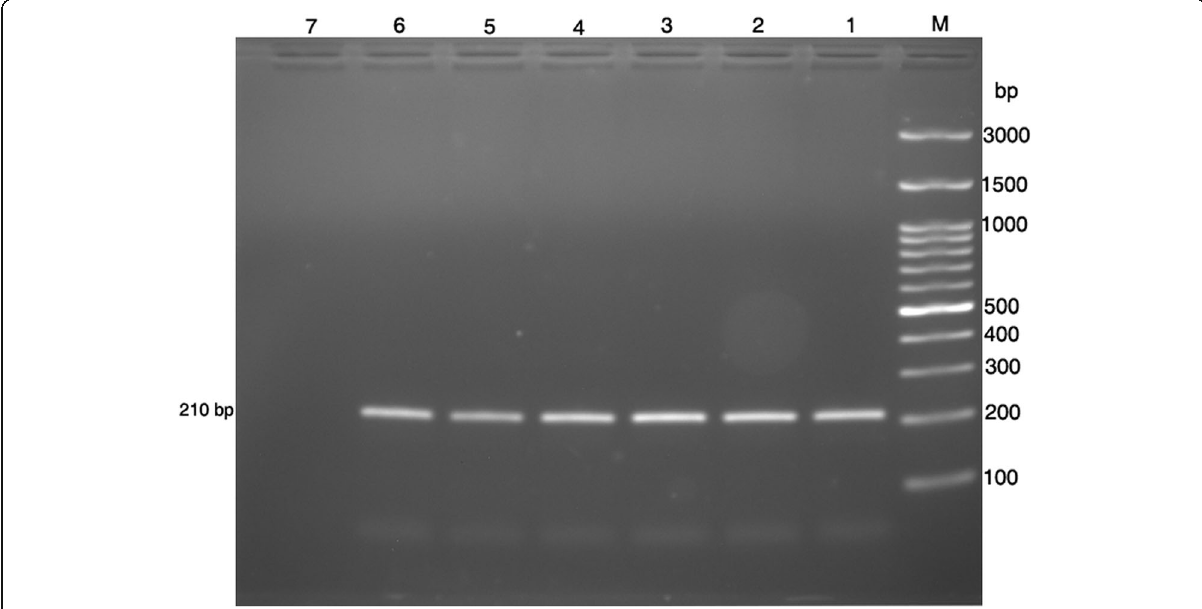
Fig. 1 The product of the PCR amplification of KCNJ11- rs5219. Samples were electrophoresed on a 2% agarose gel. Lane M: 100 bp ladder, Lane (1,2,3,4,5,6): PCR products (210 bp), Lane 7: negative control